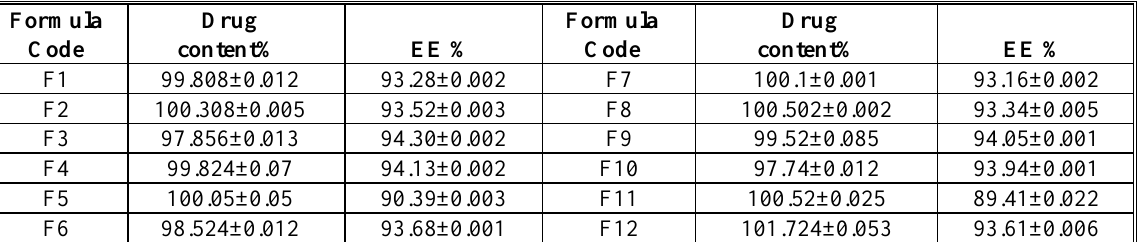
Table 3. The drug content and entrapment efficiency per cents of LXM-loaded cubosomal dispersions. (Mean ±SD)